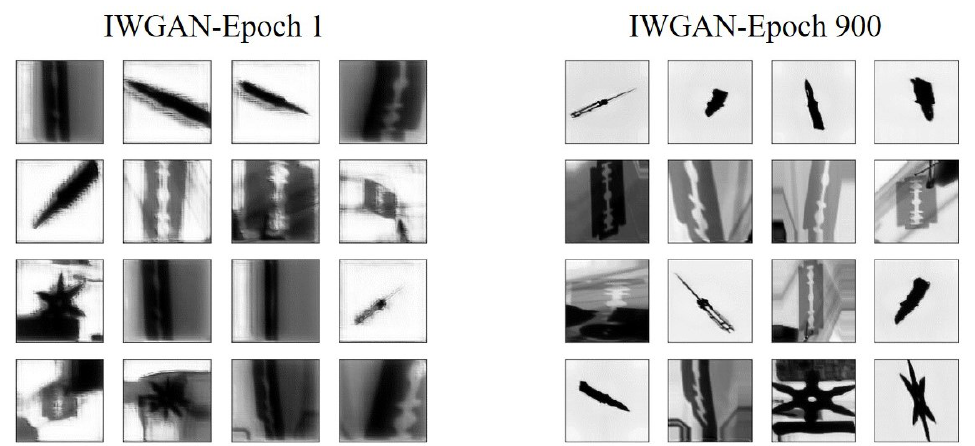
Figure 17. Generated images of IWGAN.